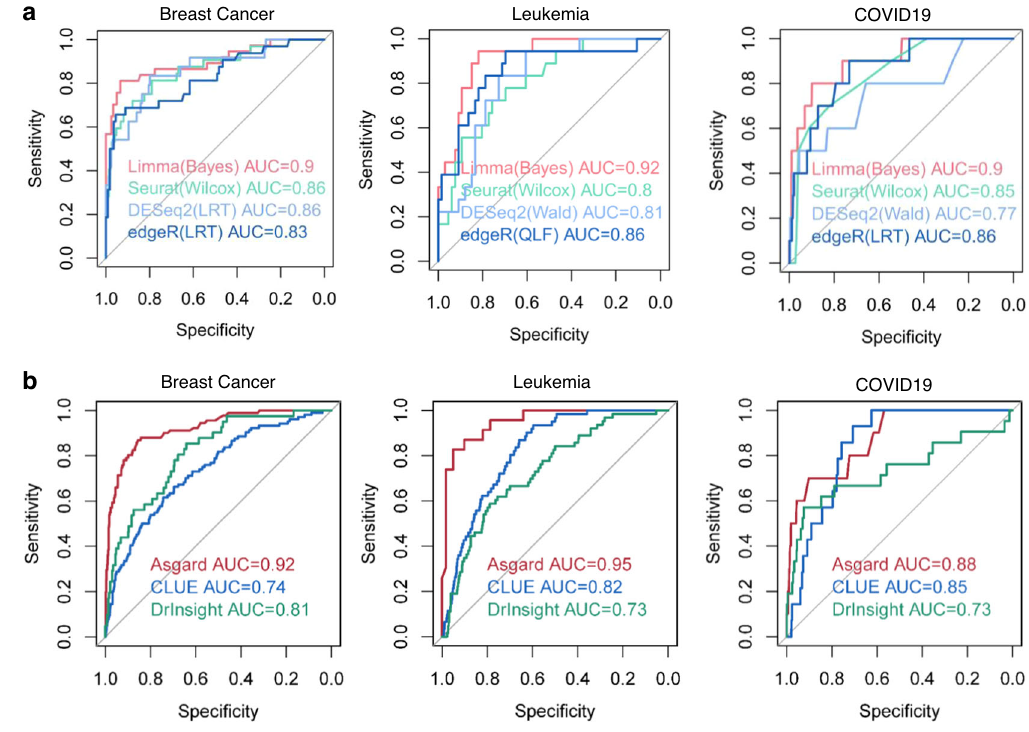
Fig. 2 | Comparing ASGARD to bulk-cell-based repurposing methods. The receiver operating characteristic (ROC) curves and area under curve (AUC) scores of the ASGARD, on advanced metastatic breast cancer, acute lymphoblastic leu- kemia, and coronavirus disease 2019 (COVID-19), respectively. a Comparison among different DE analysis methods Limma (red), DESeq2 (light blue), Seurat